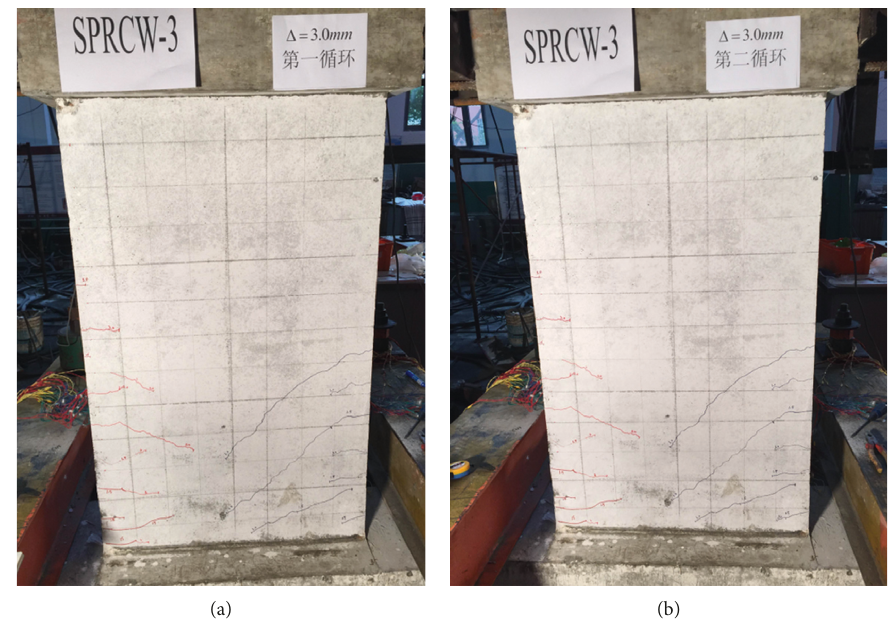
Figure 14: Diagram of cracks in the cycle with displacement Δ � 3mm. (a) First cycle. (b) Second